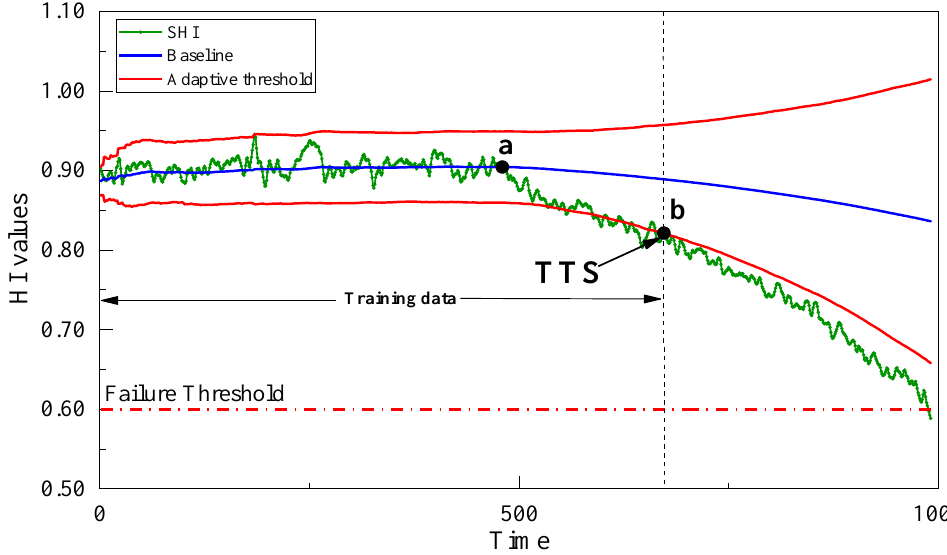
Figure 4. Determination of prediction starting point.